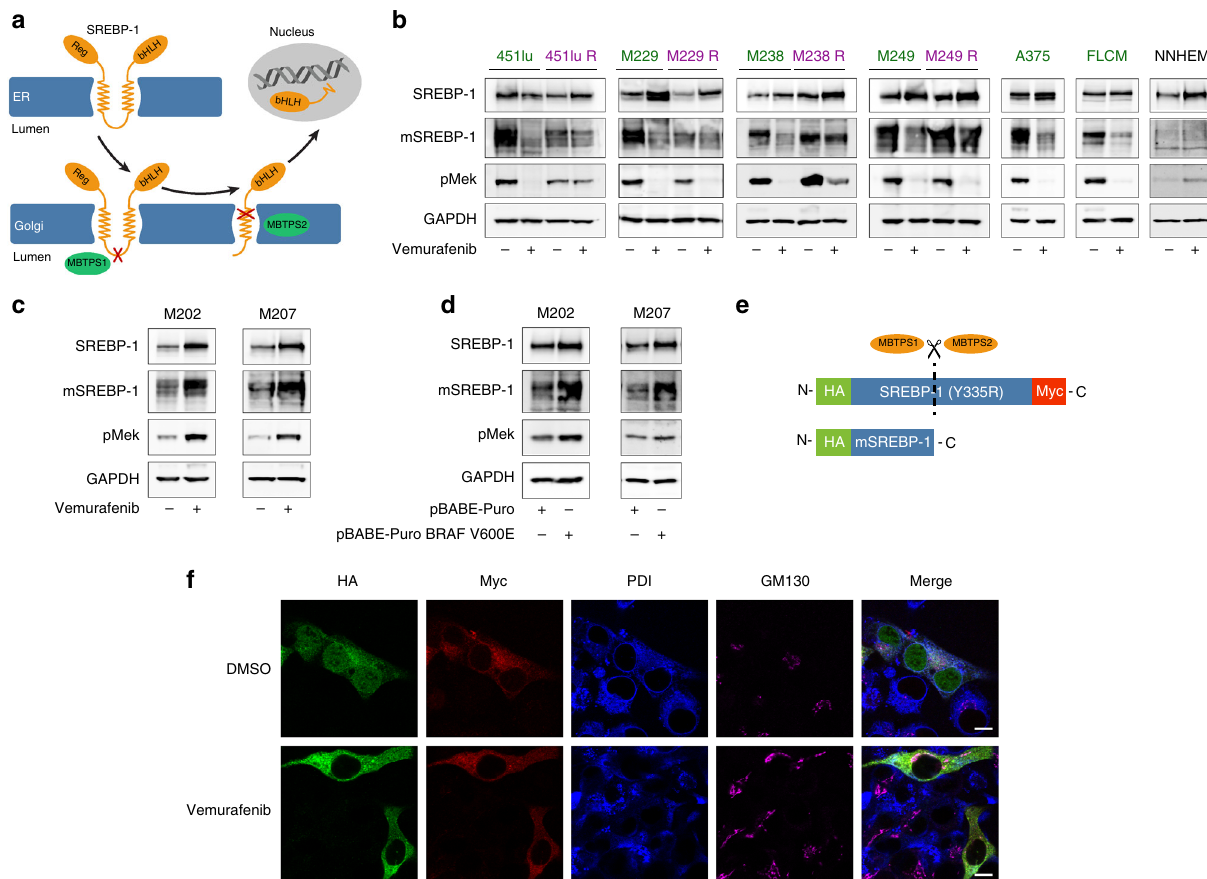
Fig. 2 Effects of vemurafenib on lipid metabolism involves SREBP-1. a Diagram illustrating the processing of SREBP: through SCAP interaction, SREBP is transported from the ER to the Golgi where it is consecutively cleaved by two proteases, yielding transcriptionally active, mature SREBP (mSREBP). b – d Western analysis of SREBP-1 (full-length and mature) and pMEK (Ser217/221). GAPDH is used as a loading control. b Western blot analysis for mSREBP levels in response to vemurafenib treatment in sensitive and resistant cells. c Western blot analysis of BRAF wild-type (but NRAS mutant) melanoma cells M202 and M207 treated with vemurafenib (5 μ M). d Western blot analysis of BRAF wild-type, NRAS mutant melanoma cells, 72 h after transfection with pBABE-Puro BRAF V600E . e Diagram illustrating the HA-SREBP-1(Y335R)-myc construct. The Y335R mutation renders the construct transcriptionally inactive. f Confocal analysis of 451lu cells expressing HA-SREBP-1(Y335R)-myc. A PDI antibody was used to mark the ER and GM130 was used for cis - Golgi. Scale bar indicates 25 μ